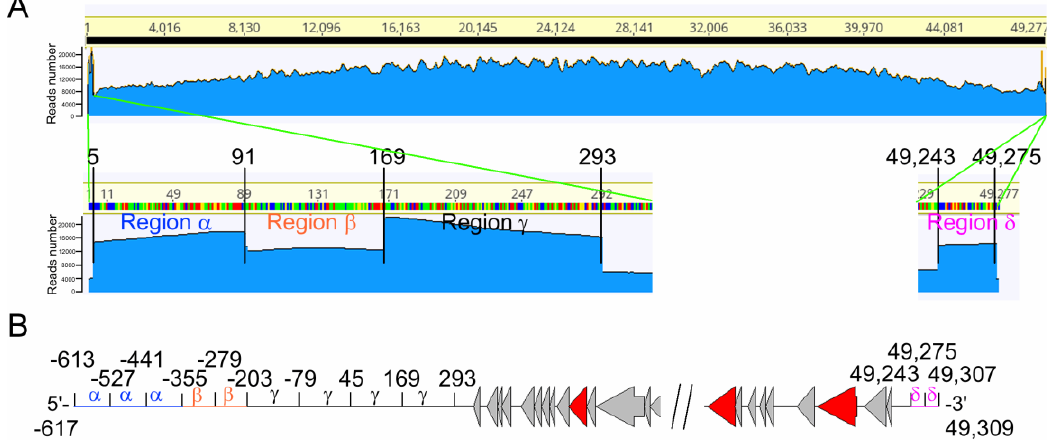
Figure 5. Terminal structure analysis of the phage vB_BthS_BMBphi genome. ( A ) Assembly of the phage genome. Using the assembled phage genome as the template, the reads archived by genome sequencing were mapped onto the phage genome. The number of the reads that were mapped to the phage genome is shown. ( B ) Predicted terminal genome structure of the phage vB_BthS_BMBphi. The repeat numbers of the repeated regions are indicated.